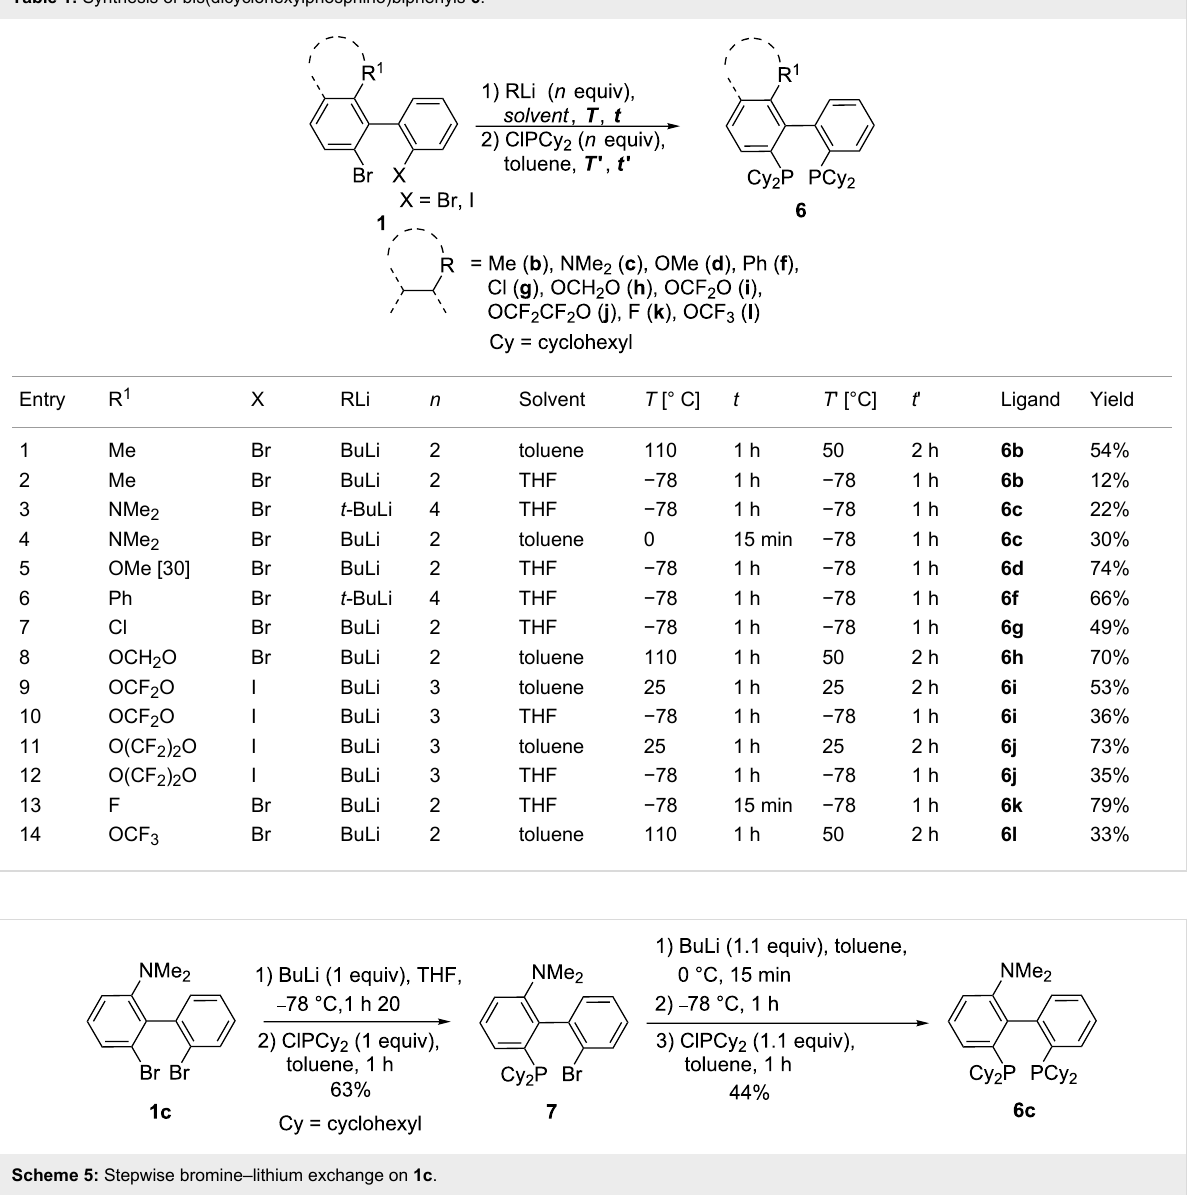
Table 1: Synthesis of bis(dicyclohexylphosphino)biphenyls 6